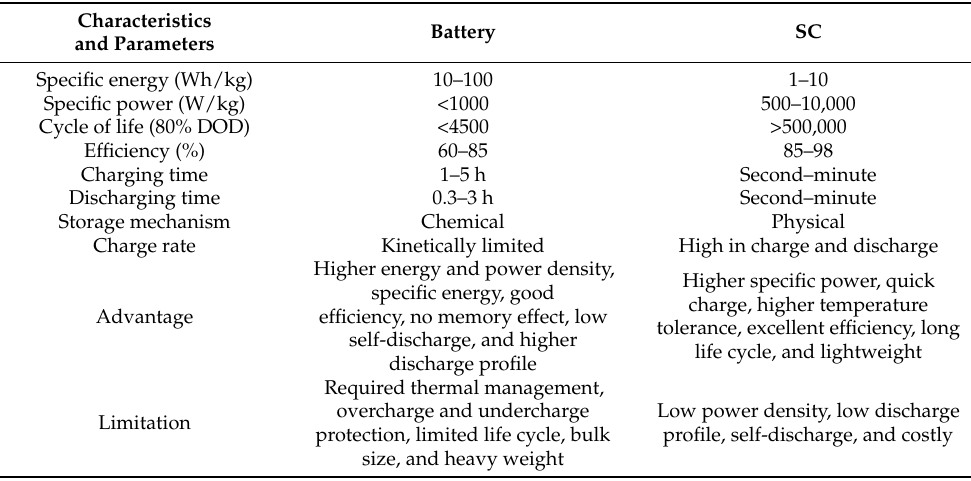
Table 2. Comparison between batteries and SCs